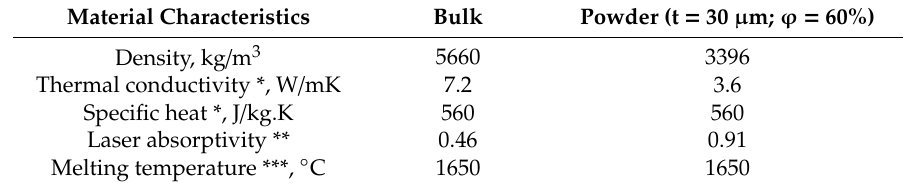
Table2. PhysicalpropertiesoftheTi-Zr-Nballoyinbulkandpowderedformsusedforprocessmodeling.